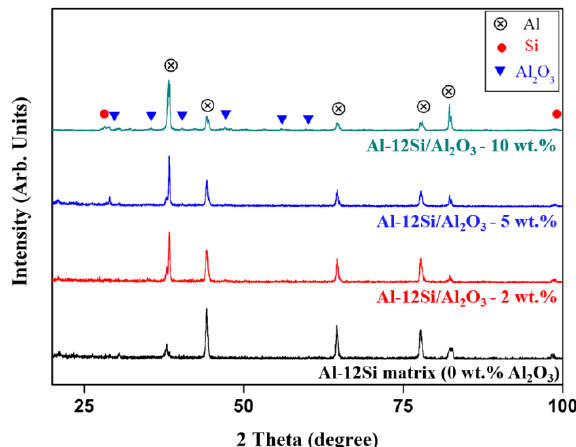
Figure 2. Scanning Electron Microscopy (SEM) image and Energy Dispersive Spectroscopy (EDS) analysis data for Al-12Si/10 wt. % Al 2 O 3 nanocomposite in the as-extruded condition.